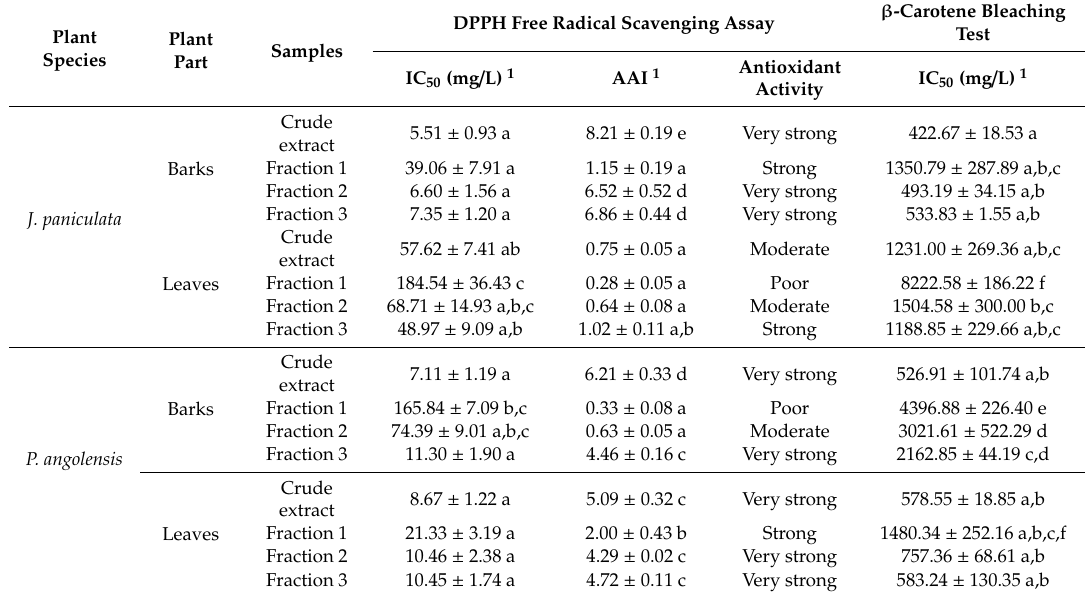
Table 6. Antioxidant properties of the